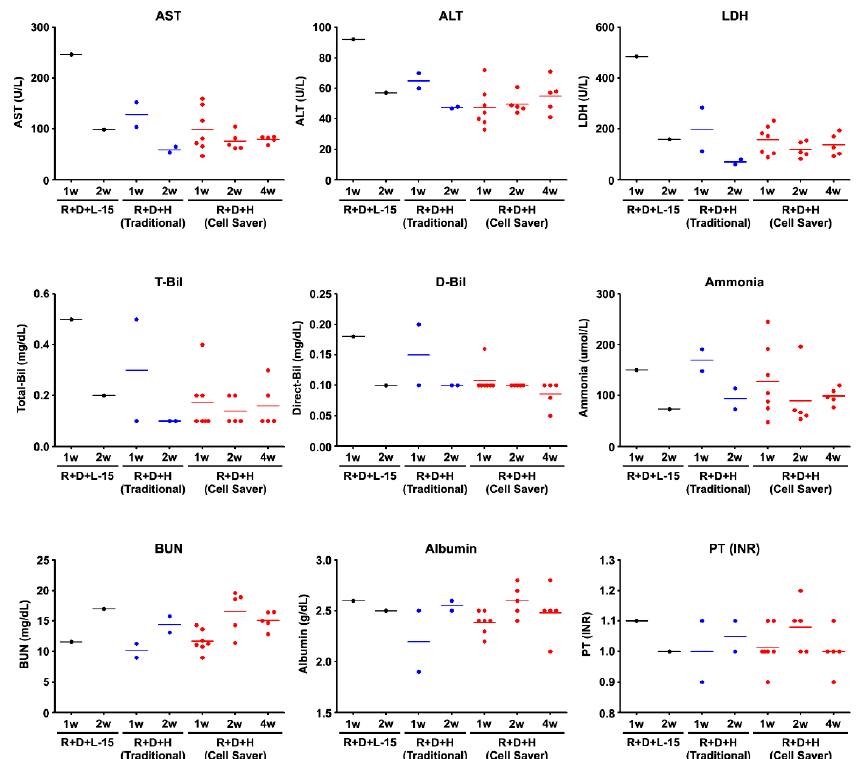
Figure 7. Serological marker changes in recipient rats after hepatocyte transplantation. R, retrorsine; D, D-galactosamine; H, hepatocyte; L-15 as a vehicle control to hepatocyte; AST, aspartate aminotransferase; ALT, alanine aminotransferase; Bil, bilirubin (T, total and D, direct); BUN, blood urea nitrogen; PT(INR), international normalized ratio of prothrombin time; LDH, lactate